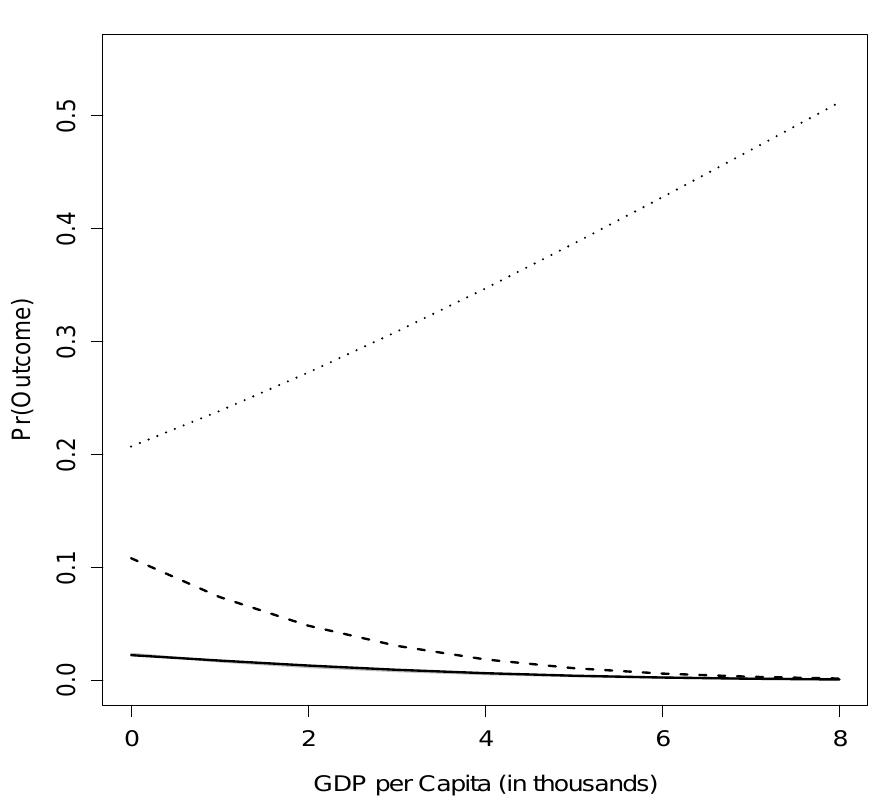
Figure 5: The probabilities of civil war predicted from the probit model are depicted as a continuous gray line. The probabilities of rebels challenging the state, of government fighting back, and of civil war from the partial observability model are depicted as dashed, dotted and continuous black lines, respectively. Note that the probabilities of civil war for both models can not be distinguished as in this case they are nearly